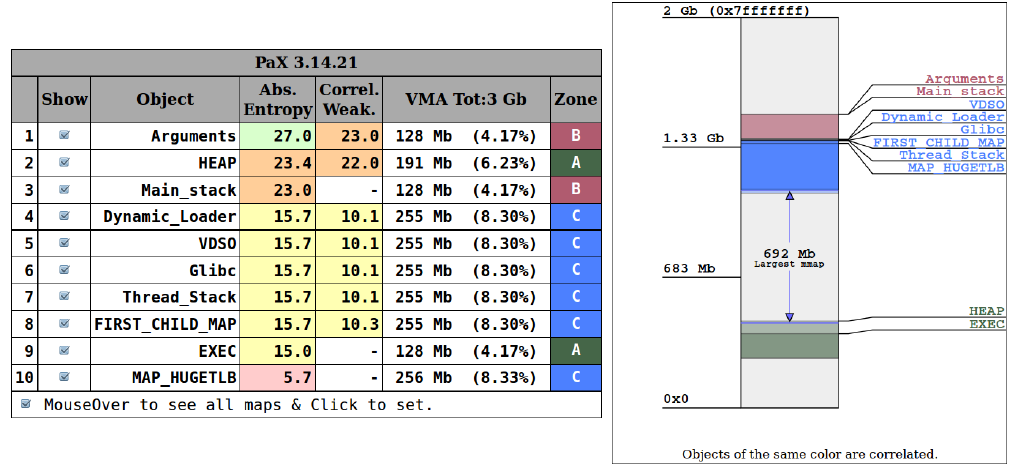
Figure 12. ASLRA: summary of PaX ASLR in a 32 bit